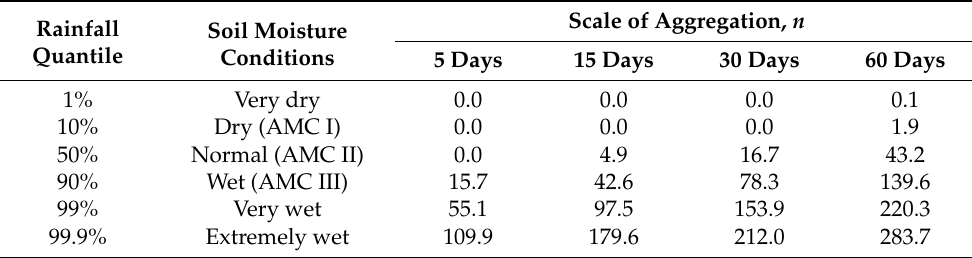
Table 2. Accumulated rainfall (mm) for various scales of aggregation at Hellinikon station and correspondence with soil moisture conditions over the study